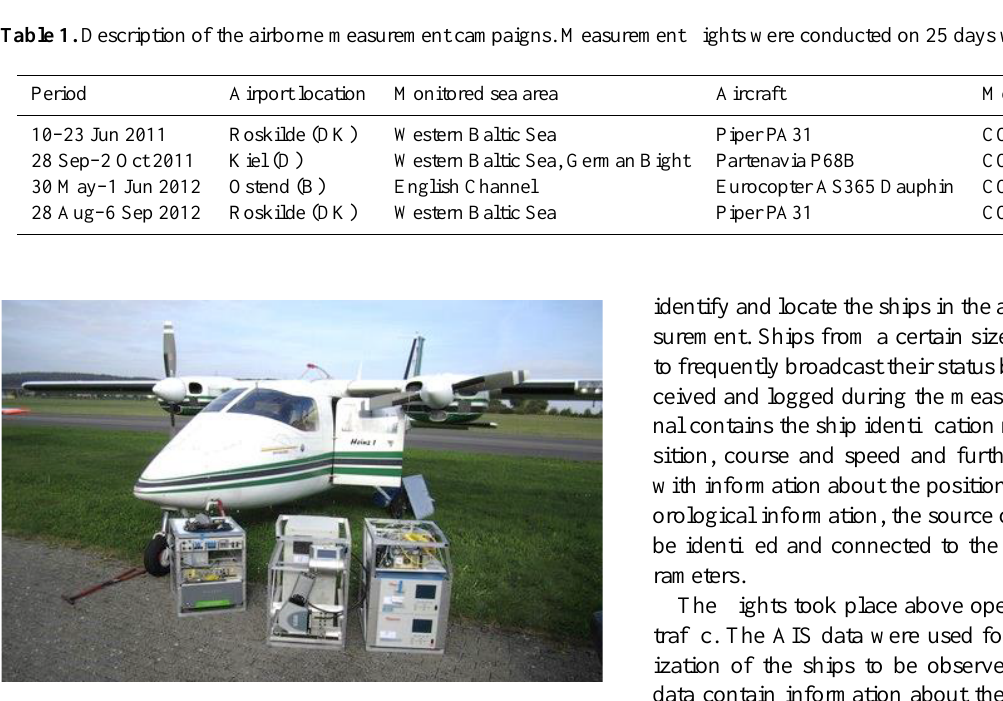
Figure 3: Instruments, mounted in racks, for ready installation in the Partenavia P68B airplane behind. The particle inlet can be seen on top of the fuselage (picture taken by B. Schneider, enviscope GmbH).